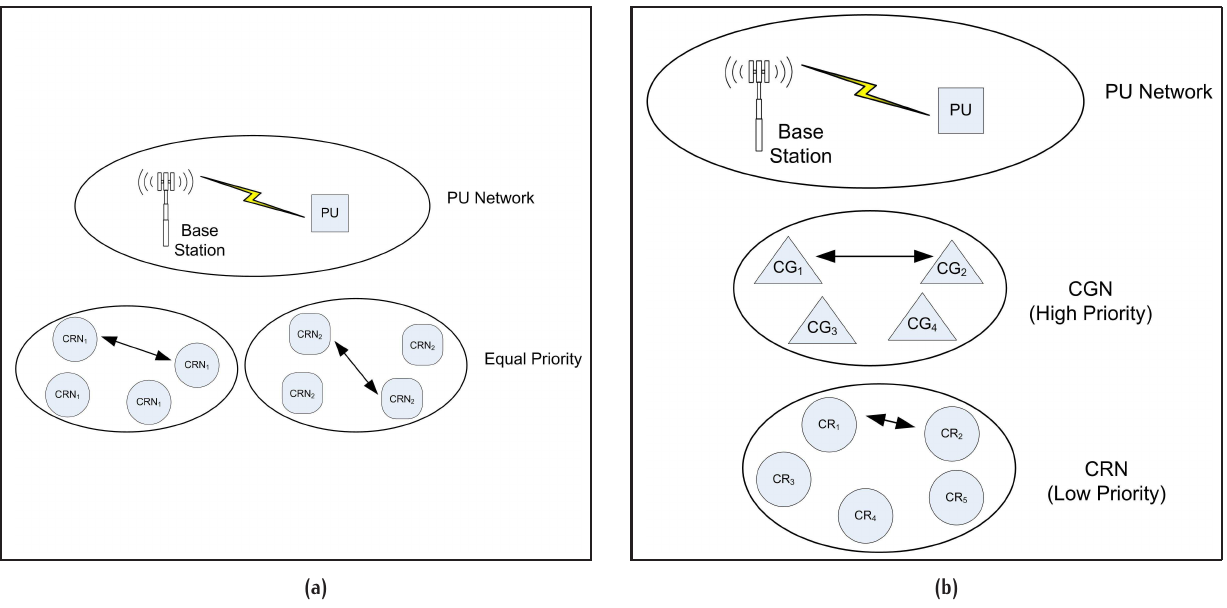
Figure 2. Logical network scenario, where two coexisting CR networks have different priority of spectrum access while yielding to a primary user. (a) Equal Access (CRN1 and CRN2 ). (b) Prioritize Access (CGN and